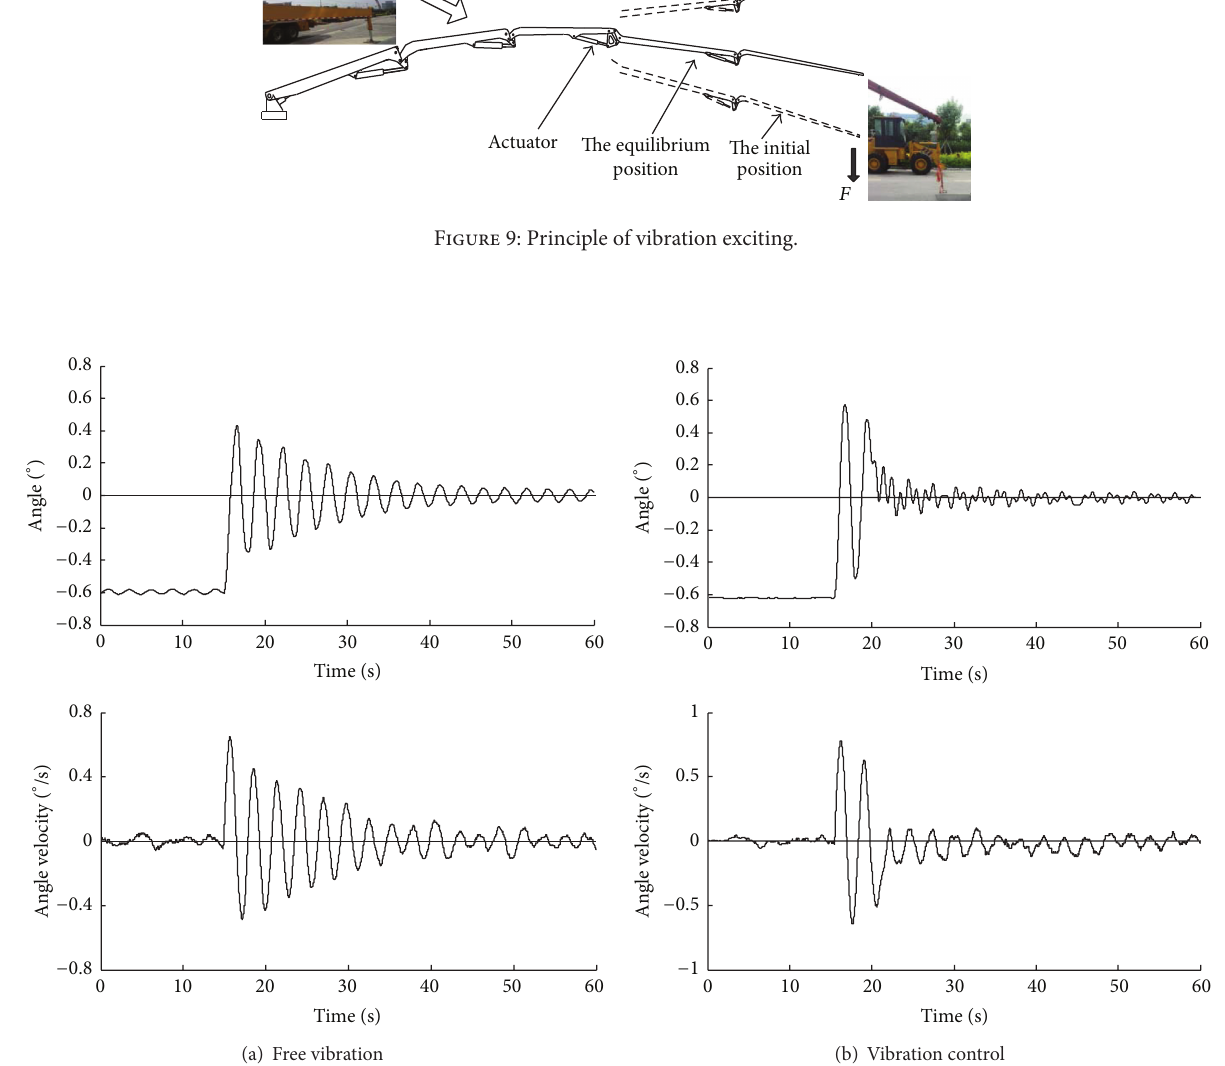
Figure 10: Experimental results of the fourth boom under single impulse